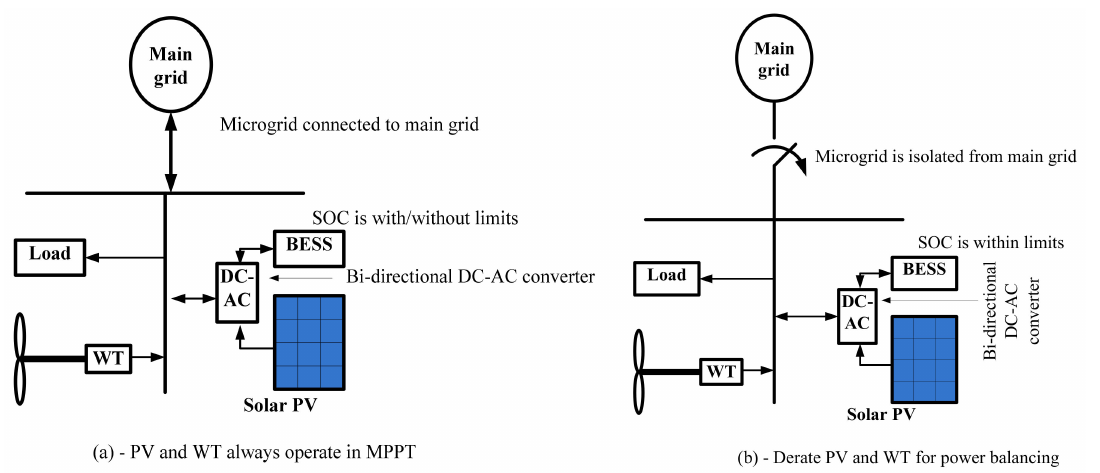
Figure 3. ( a ) Power dispatch mode in connected grid, ( b ) Un-dispatched power mode in iso- lated